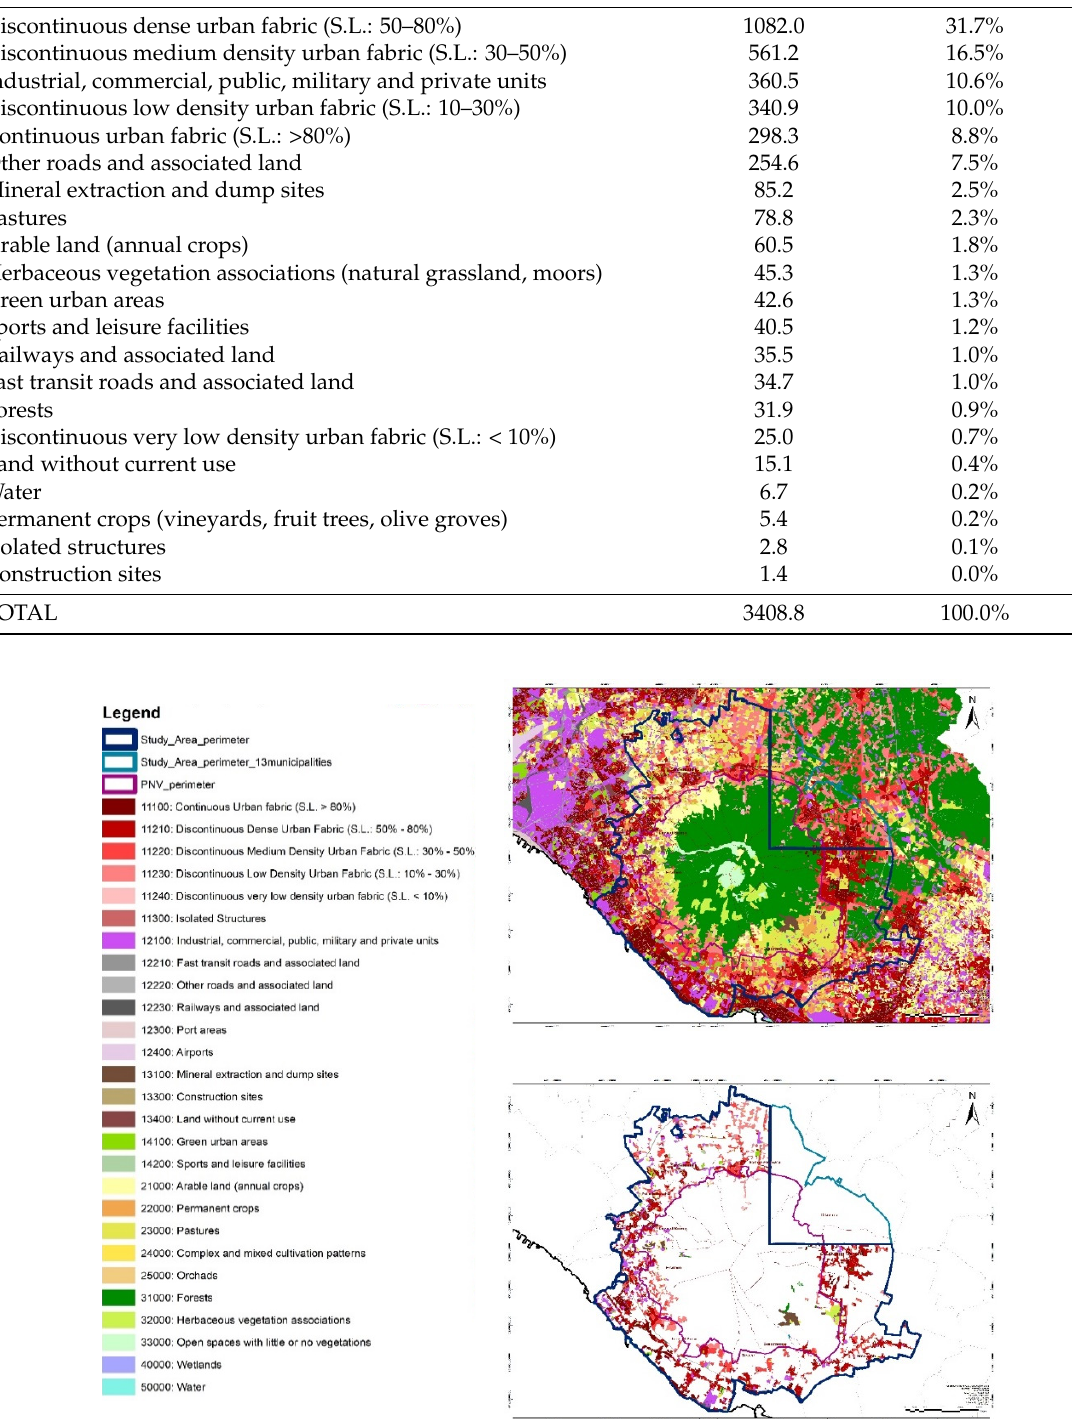
Figure 11. Urban Atlas (2018) land uses in Naples province (figure above) and urban expansion between